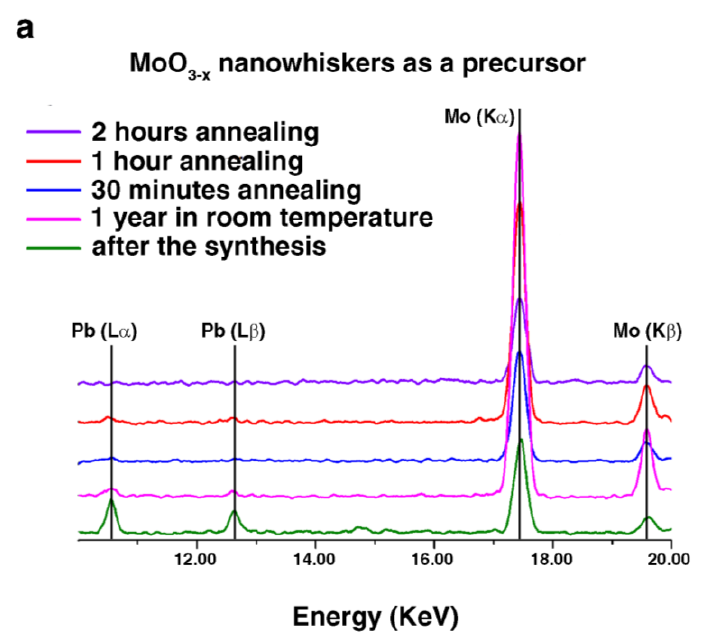
(2) nanotubes as a 2